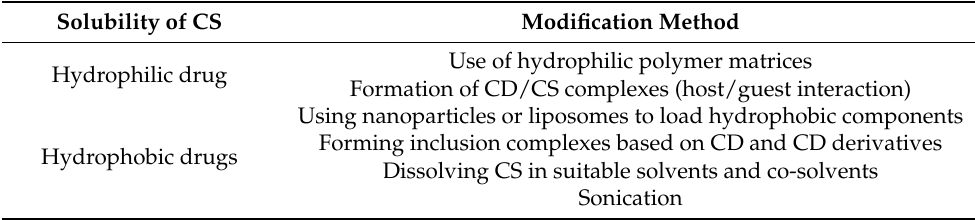
Table 4. Approaches to modifying drug release from polymeric patches.